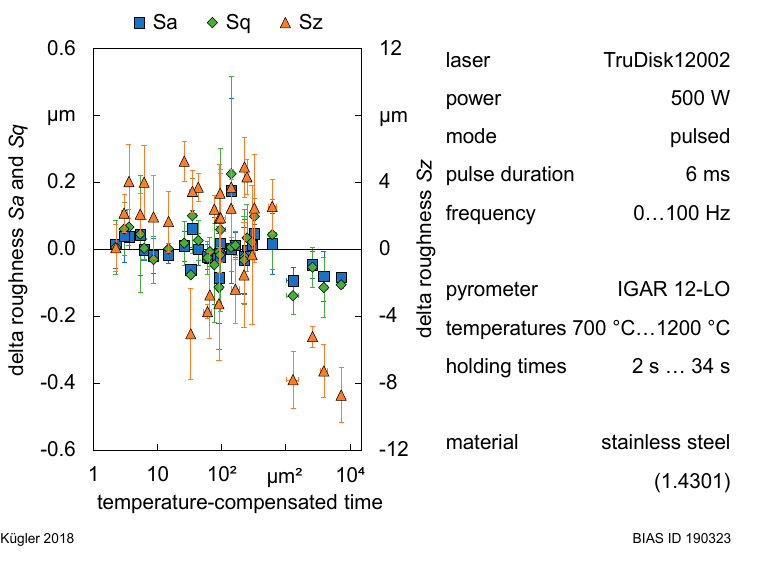
Figure 3. Roughness values Sa , Sq , and Sz of laser-heated 1.4301 sheets.